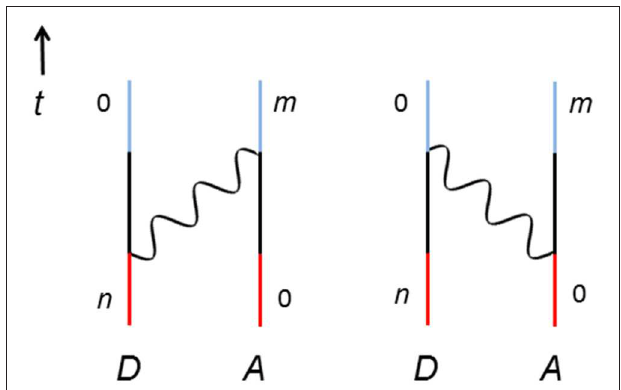
FIGURE 2 | Two time-orderings for RET between a donor ( D ) and an acceptor ( A ). The vertical lines denote the two molecules, wavy lines are the photons, n and m represents the excited state of D and A , respectively, and 0 is their ground state; time, t , increases up the graph. Red, black, and blue lines represent the initial, intermediate, and final system